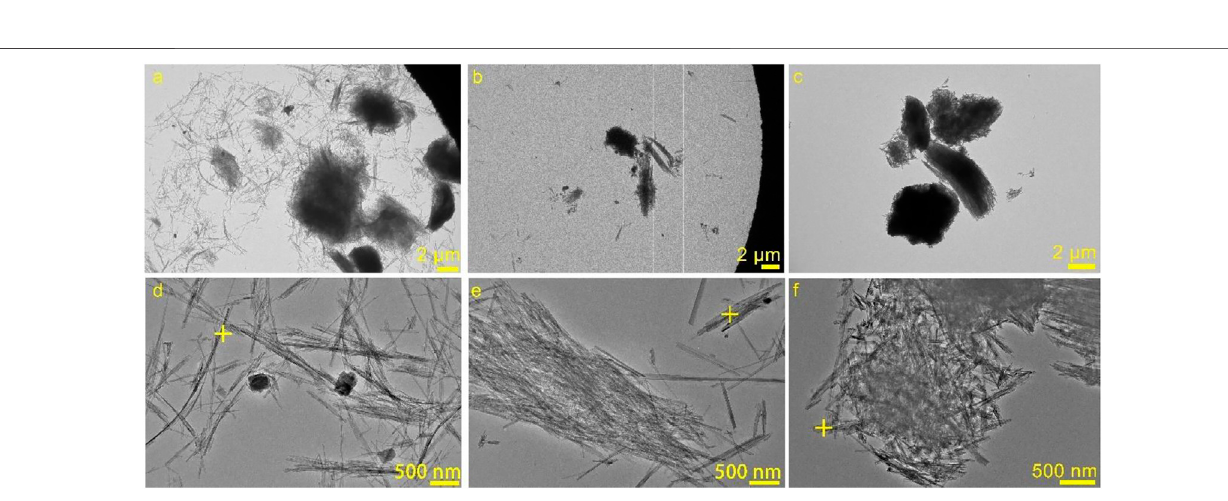
FIGURE 3 | TEM images of (A, D) Sep, (B, E) Al-3.50-Sep, and (C, F) Al-70.0-Sep.